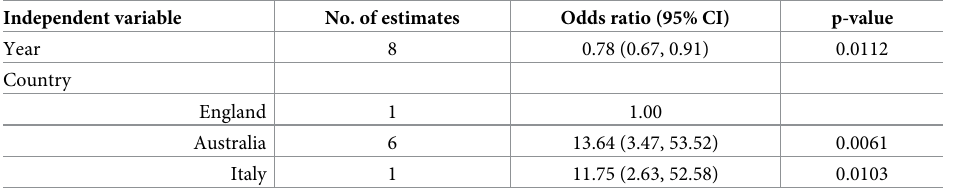
R 2 : 0.85 (estimate of proportion of between-study variance explained by model). a Appropriateness was assessed using the McGeer